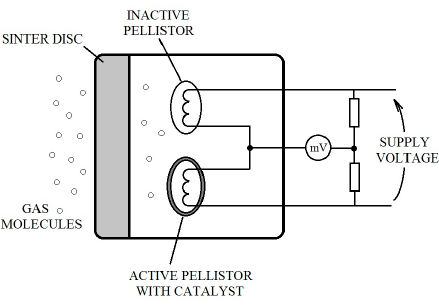
Figure 6. Scheme of pellistor-type sensor.